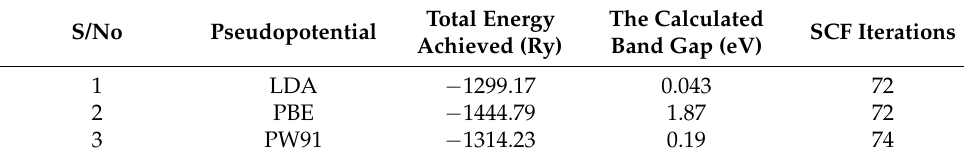
Table 3. The effect of exchange-correlation in the Fermi energy. S/No